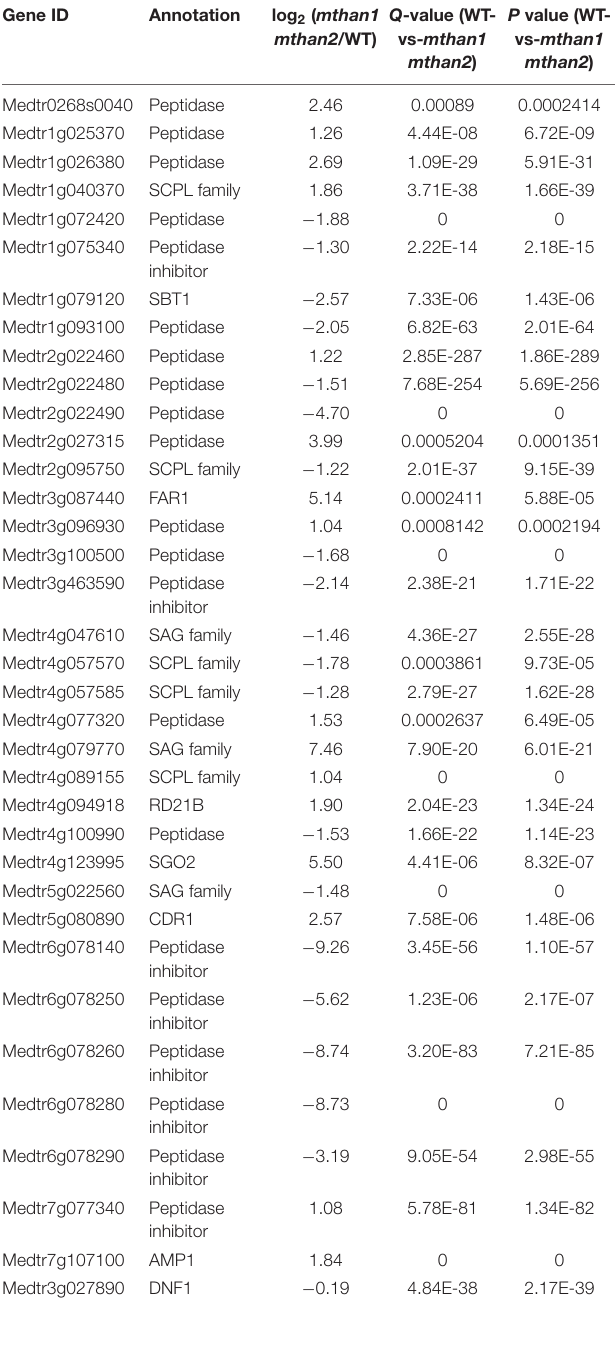
TABLE 2 | Peptidase and peptidase inhibitor genes differentially expressed in mthan1.mthan2